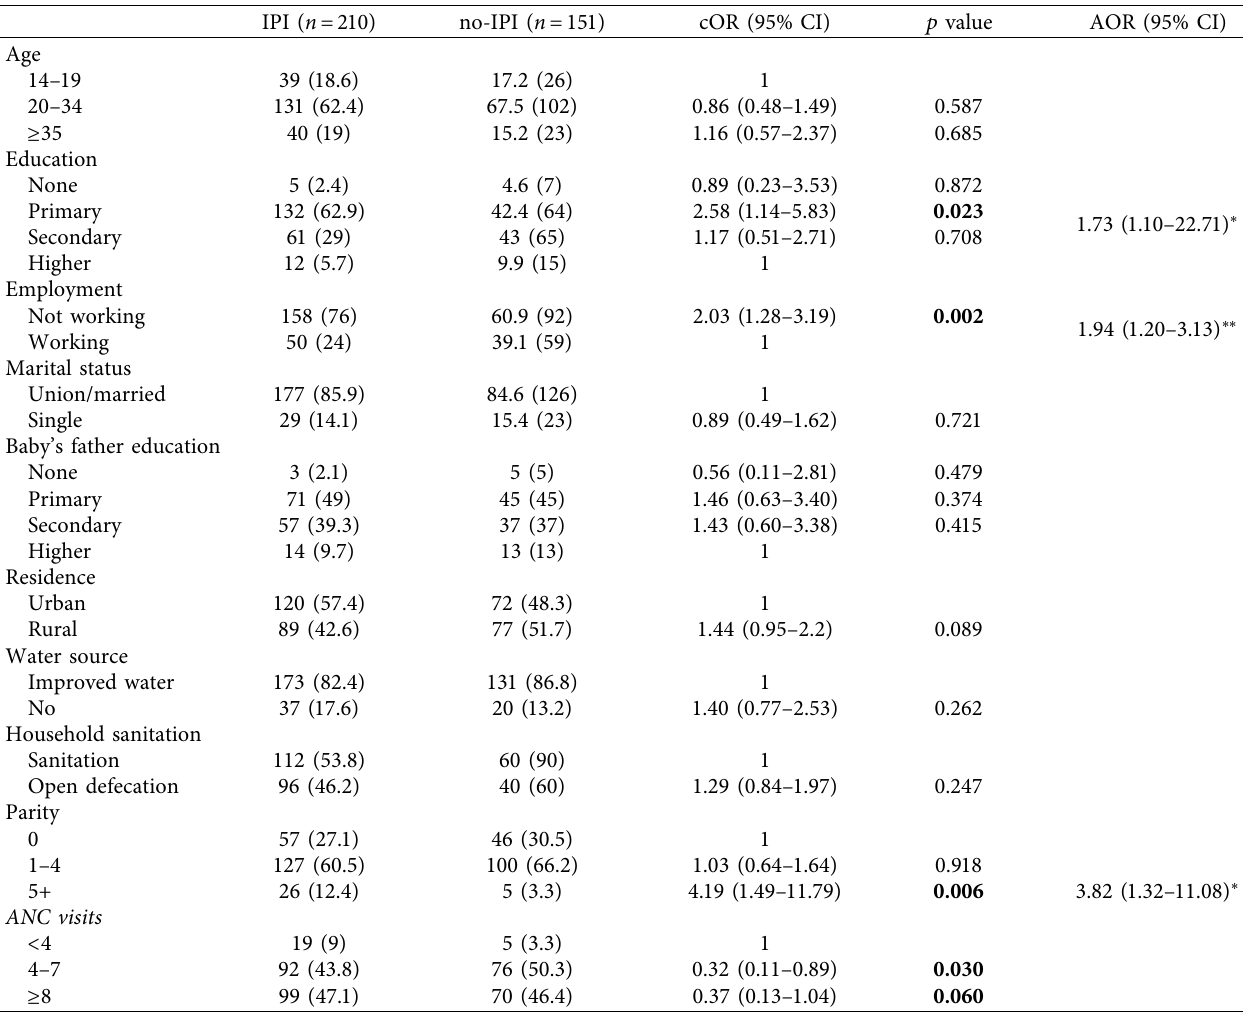
Table 5: Results of univariable and multivariable logistic regression analysis regarding IPI associated